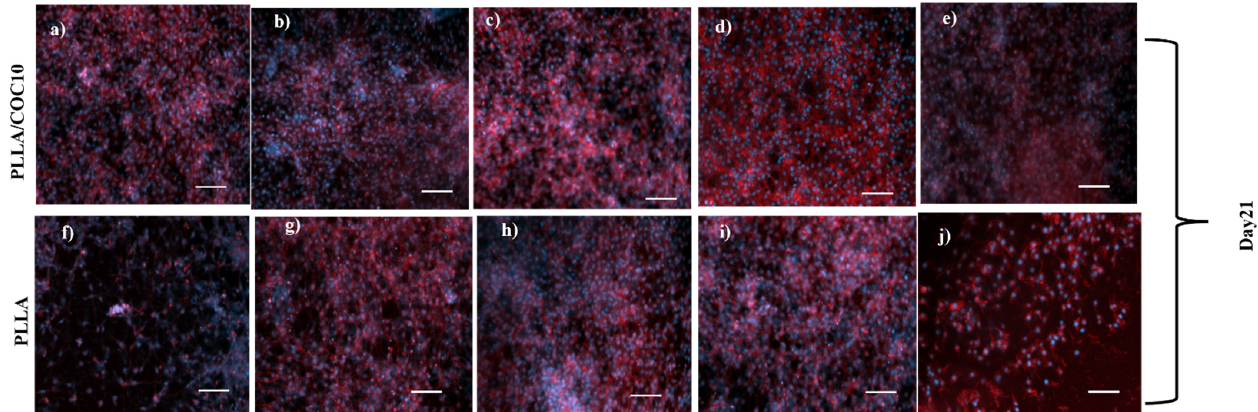
Figure 10. F-actin and DAPI staining in pre-osteoblast cells cultivated on PLLA/COC10-nHA and PLLA/nHA nanocomposites on week 2 (14 days ( a–j )) and week 3 (21 days ( a–j )). The scale bar is 1 µ m in diameter in all the images. Nanocomposites had nHA in 1 wt%, 5 wt%, 10 wt%, and 20 wt%. The color of F-actin was red, while the fluorescence of DAPI-labeled nuclei was blue. The DAPI staining revealed the morphology of the nuclei. A large number of pre-osteoblast cell nuclei suggested that the PLLA/COC10-nHA were cytocompatible with the cell line. The presence of actin filaments in cells indicates that they were alive. Actin filaments revealed a complex cytoskeleton with well-defined direction and connectivity in cells.